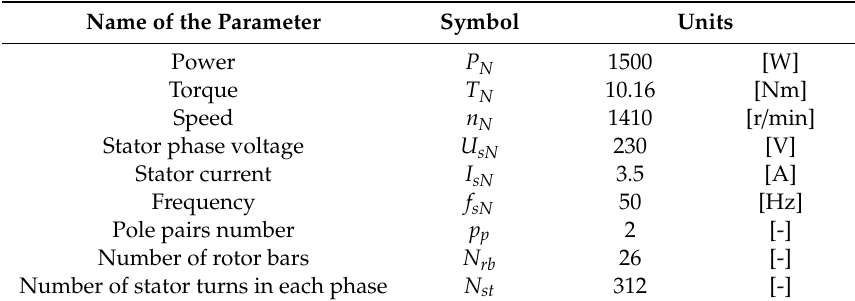
Table A1. Rated parameters of the tested induction